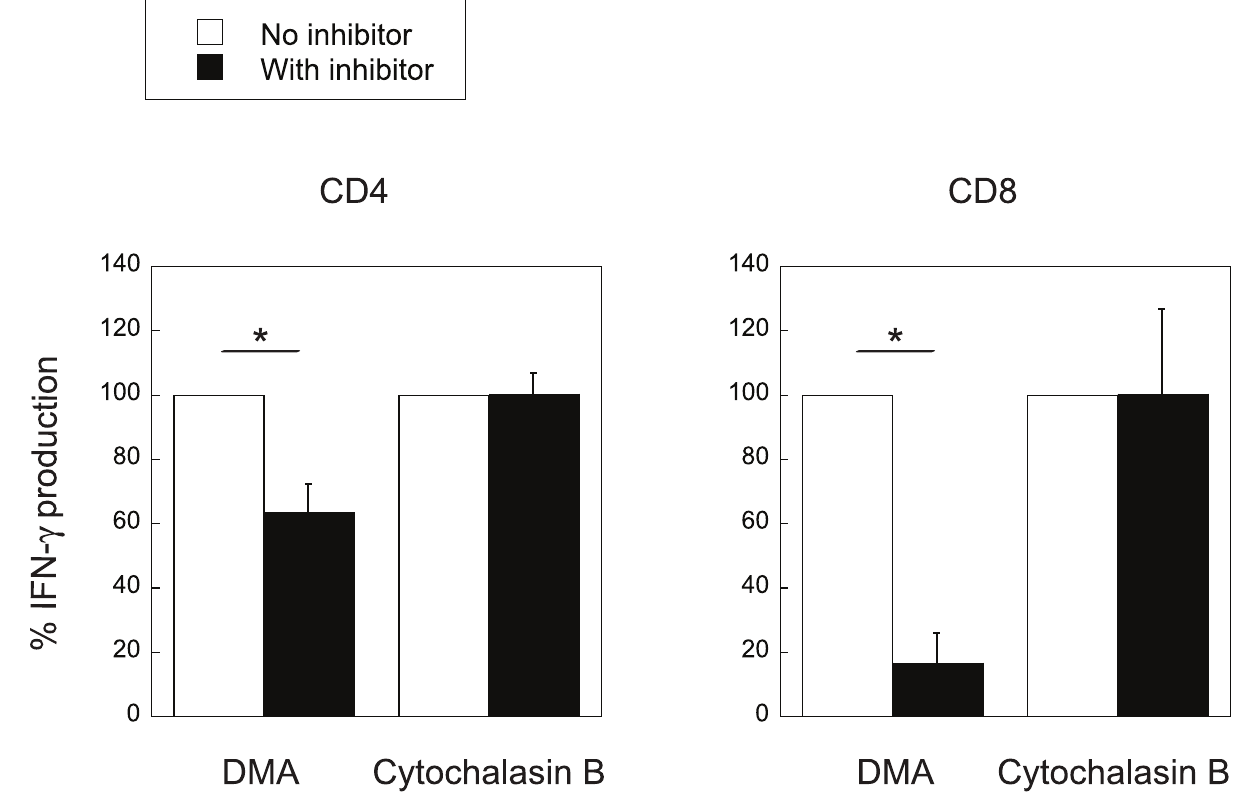
Figure 5. IFN- c production by splenic CD4/CD8 + T cells of mice immunized with OVA after co-culture with CD11c + cells pulsed with OVA coupled to oleoyl liposomes. Splenic CD4/CD8 + T cells were taken from mice immunized with OVA and were cultured with CD11c + cells pulsed with OVA coupled to oleoyl liposomes with or without inhibitors as described in Materials and Methods. IFN- c production of T cells in the supernatants in the absence of inhibitors was normalized to 100%. Data represent the mean values 6 SD of triplicate culture. Asterisk, significant ( p , 0.01) difference as compared with the ‘no inhibitor’ group.